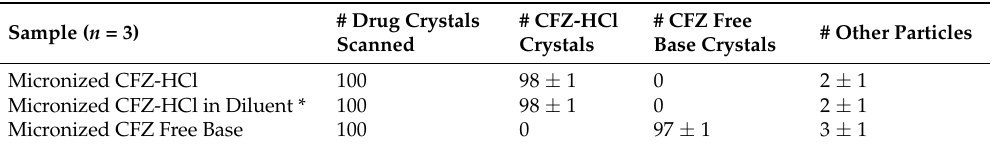
Table 1. Quality and stability of single CFZ-HCl and CFZ free base micronized drug crystals measured by single crystal Raman micro-spectroscopy.